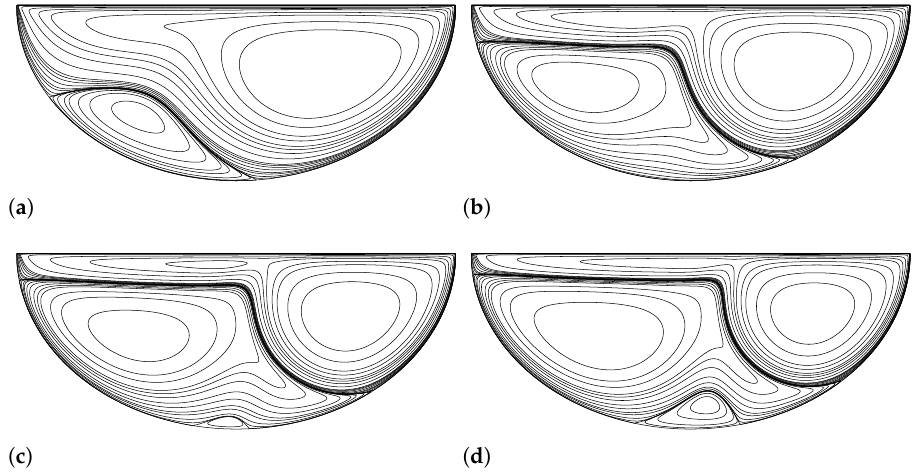
Figure 14. The evolution of the 1st solution of driven semi-elliptical cavity flow until Re = 7000 for D = 0.8 aspect ratio. ( a ) Re = 1000 (1st solution). ( b ) Re = 3000 (1st solution). ( c ) Re = 5000 (1st solution). ( d ) Re = 7000 (1st